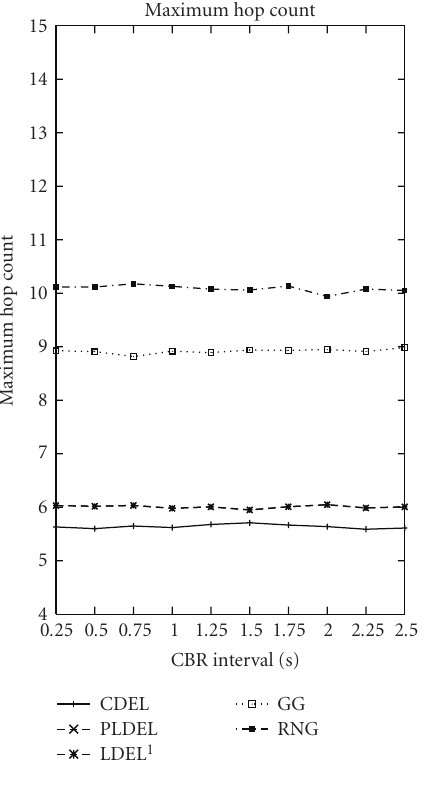
Figure 14: Maximum hop count.